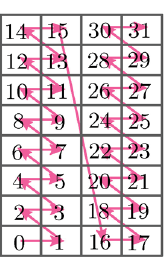
Fig. 7 Typical thread execution order (raster pattern) for a 4 × 8 block of pixels on an nVidia